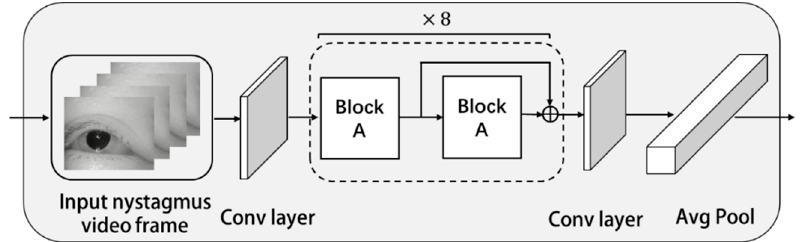
Figure 1. Network structure of feature extraction.